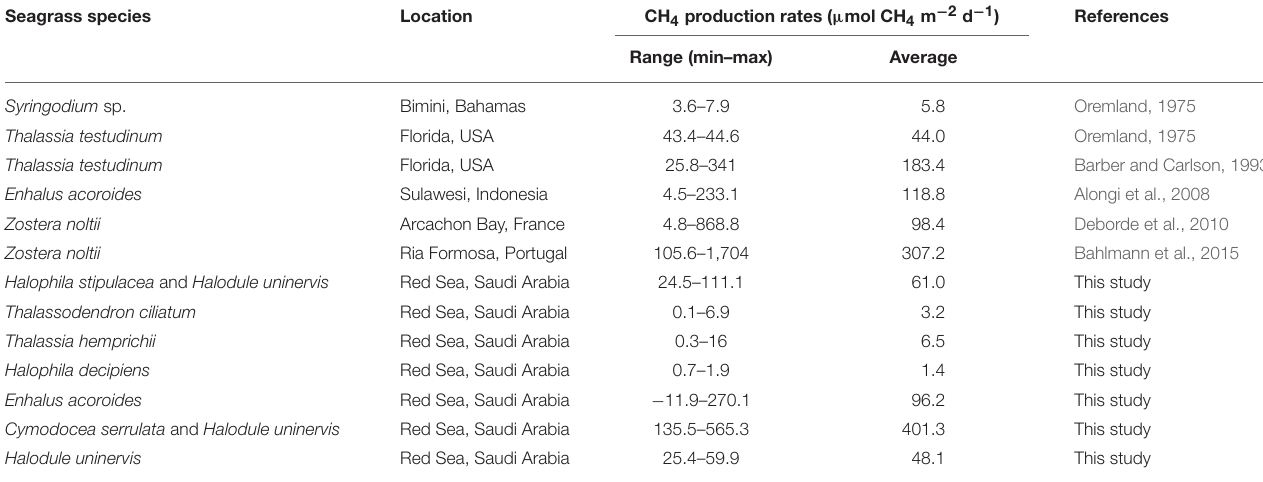
TABLE 1 | CH 4 production rates by seagrasses reported in the literature and in this study. Seagrass species